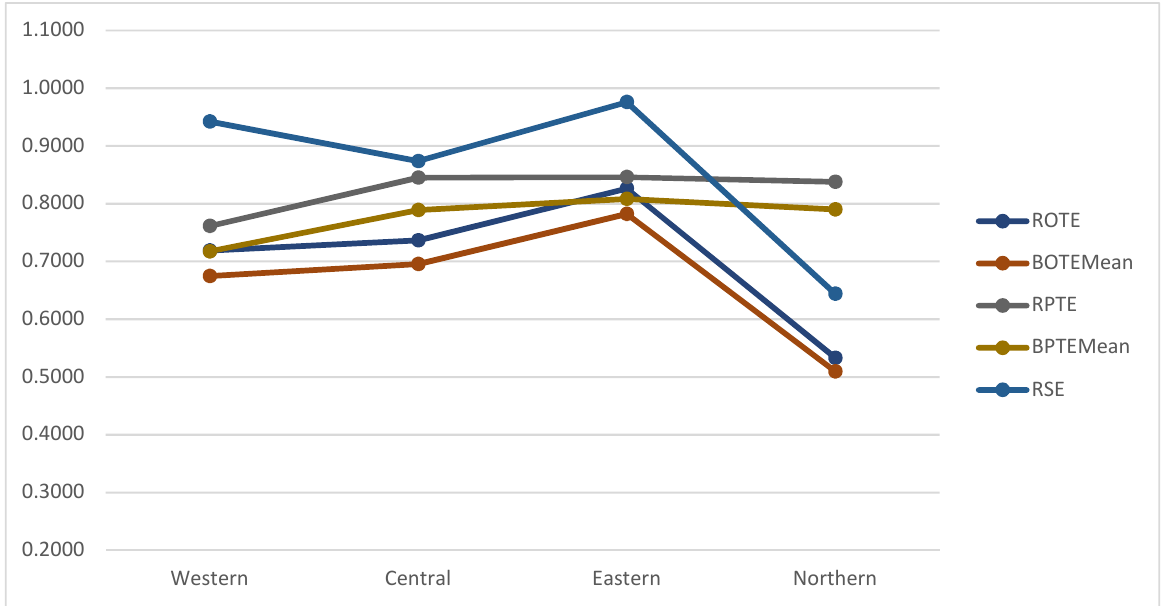
Figure 3. Efficiency scores of the power-generating companies per region.